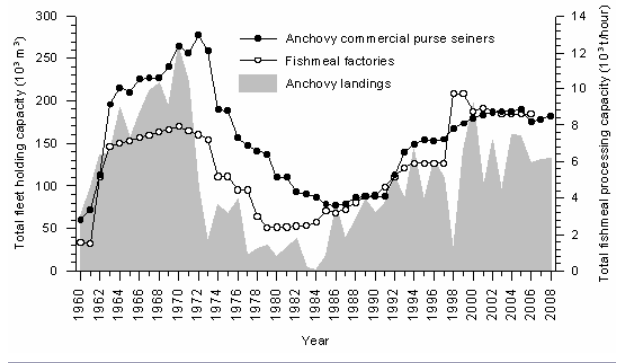
Fig. 2 . Historical evolution of Peruvian anchovy landings, anchovy fishing vessels, and fishmeal factories between 1960 and 2008. Anchovy landings (shaded area) correspond to landings presented in Fig.